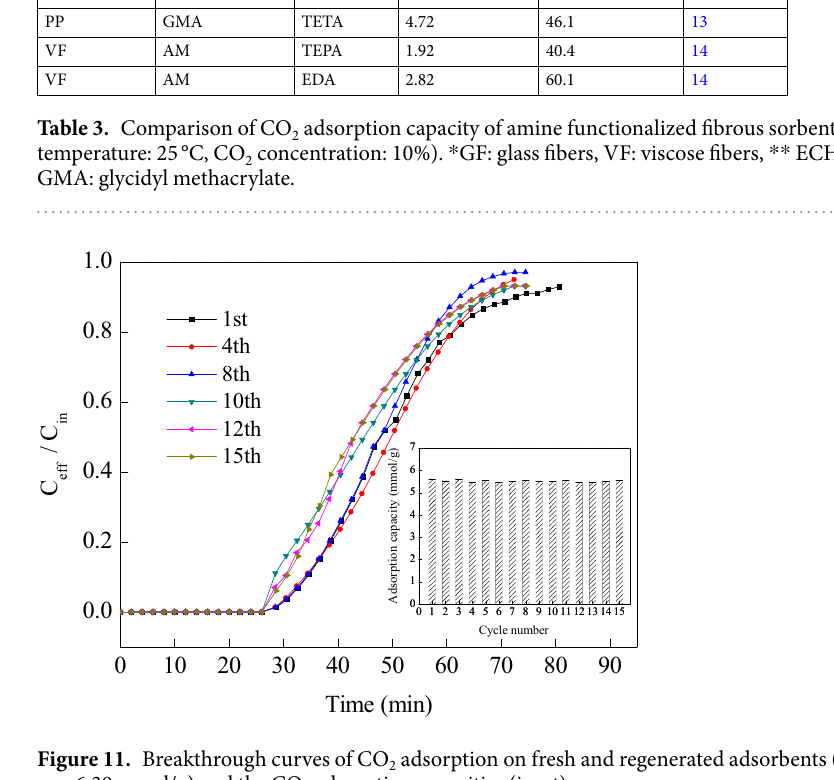
Figure 11. Breakthrough curves of CO 2 adsorption on fresh and regenerated adsorbents (alkyl amino content was 6.39 mmol/g) and the CO 2 adsorption capacities